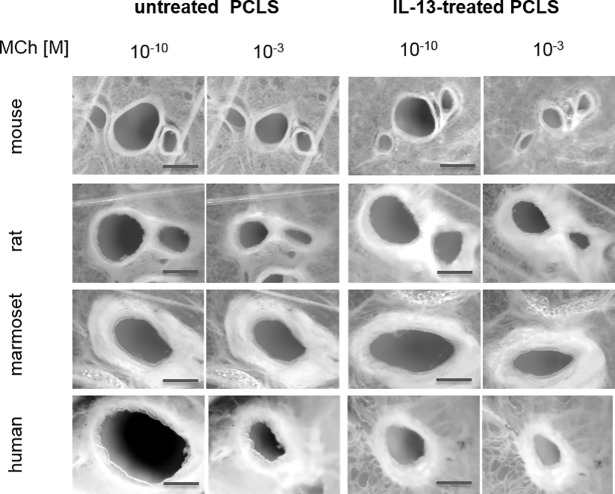
Methacholine-induced airway constriction in mouse, rat, marmoset, and human PCLS compared with pre-incubation with IL-13 of the corresponding species (except for marmoset, rhIL-13 was used).Macroscopic images of precision-cut lung slices of untreated PCLS (control) or PCLS treated with 8 nM of IL-13 for six hours prior to stimulation with 10−10 M and 10−3 M methacholine (MCh), the lowest and the highest concentration, respectively. Scale bar: 500 μm.